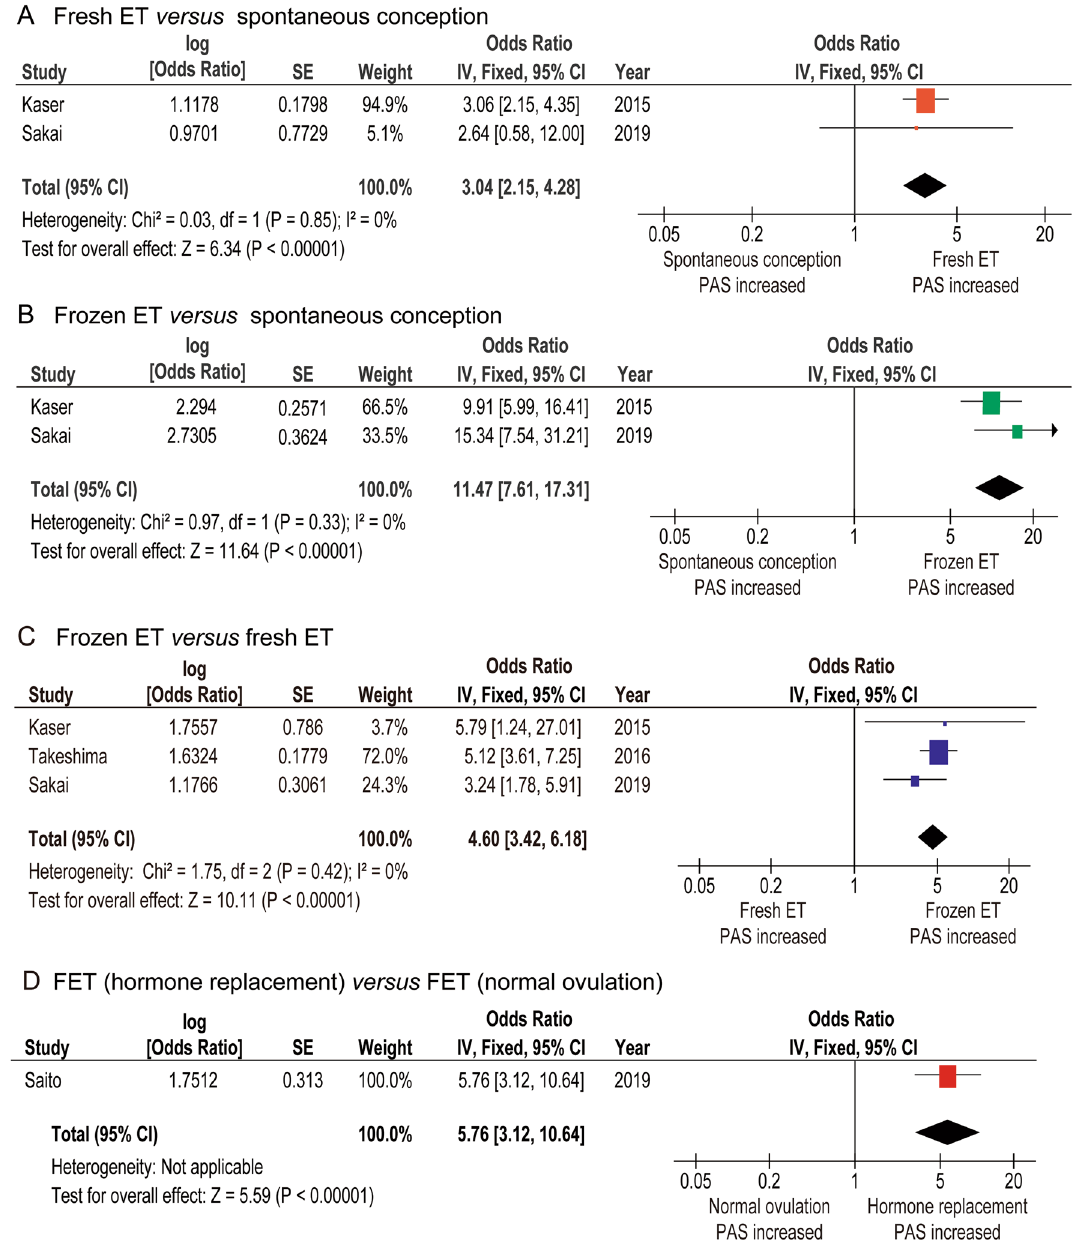
Figure 3. The effect of fresh ET, frozen ET, FET with normal ovulatory cycle, and FET with hormone replacement cycle on PAS. The pooled odds ratio for PAS (A) fresh ET versus spontaneous conception, (B) frozen ET versus spontaneous conception, (C) fresh ET versus frozen ET, and (D) frozen ET with hormone replacement cycle versus frozen ET with normal ovulatory cycle are shown. Since the numbers after the third decimal places for the lower or upper confidence interval are omitted in most studies, some calculated values of OR using Revman ver. 5.4.1™ may be different from the original values. PAS placenta accreta spectrum, OR odds ratio, CI confidence interval, ET embryo transfer, FET frozen embryo